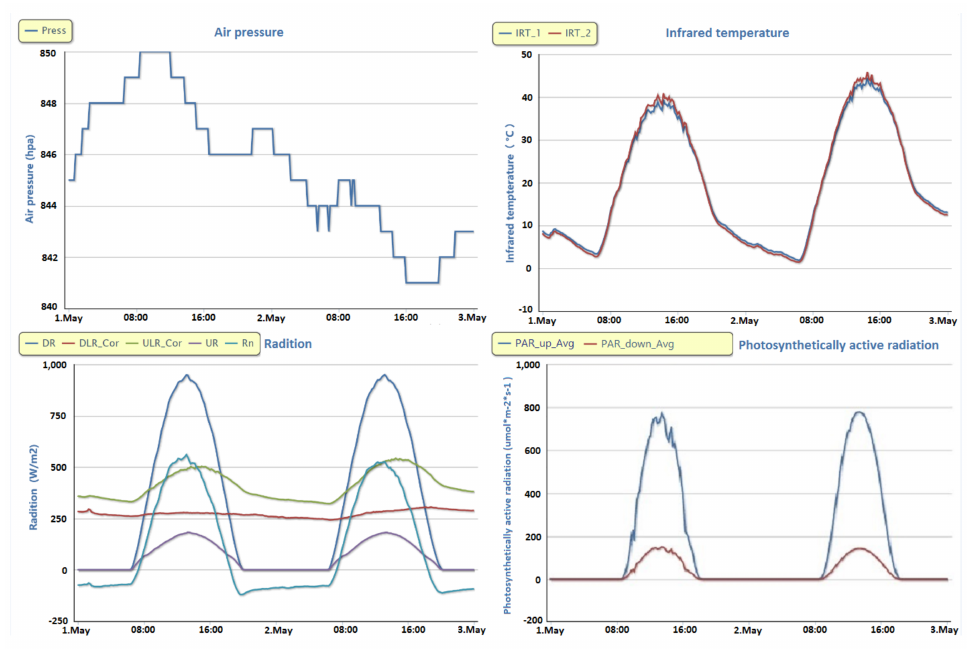
Figure 12. Part of the equipment status inspection report of the